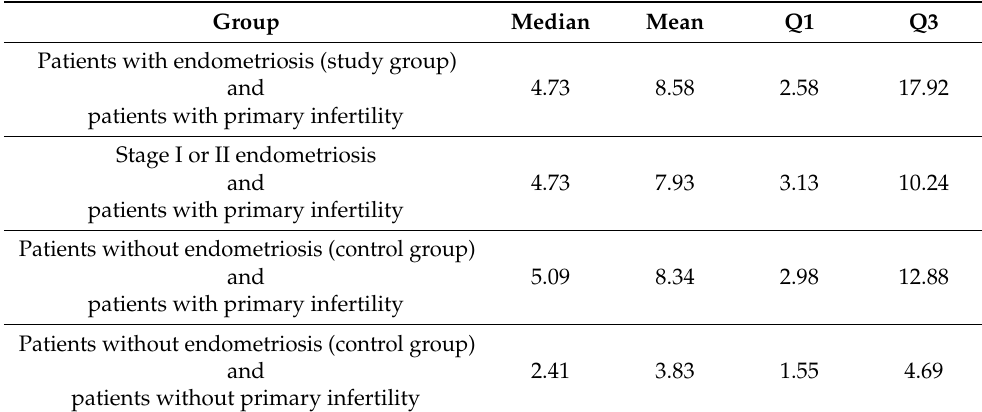
Table 6. Characteristics of CDH 12 concentrations (ng/mL) within different groups (including patients with primary